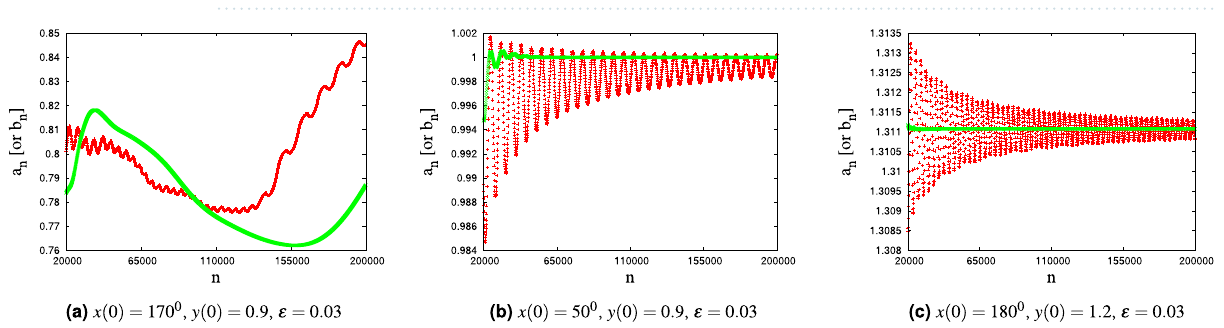
Figure 3. FLI map and FLI-based index map of the dynamics index in the case of the dynamic model (1) for ε = 0.02 . The colors are coded as follows: yellow—chaos, magenta—rotational motions, blue—librational motion.